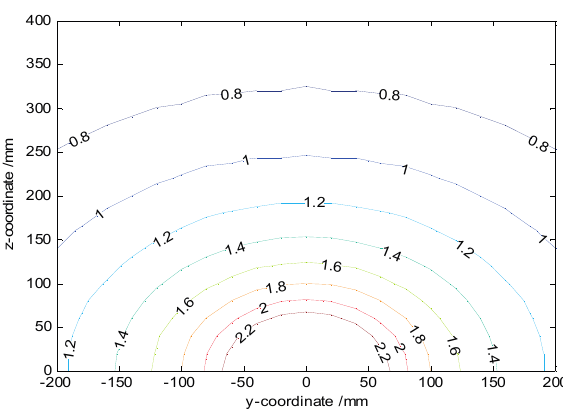
Figure 12. The peak spectral component.